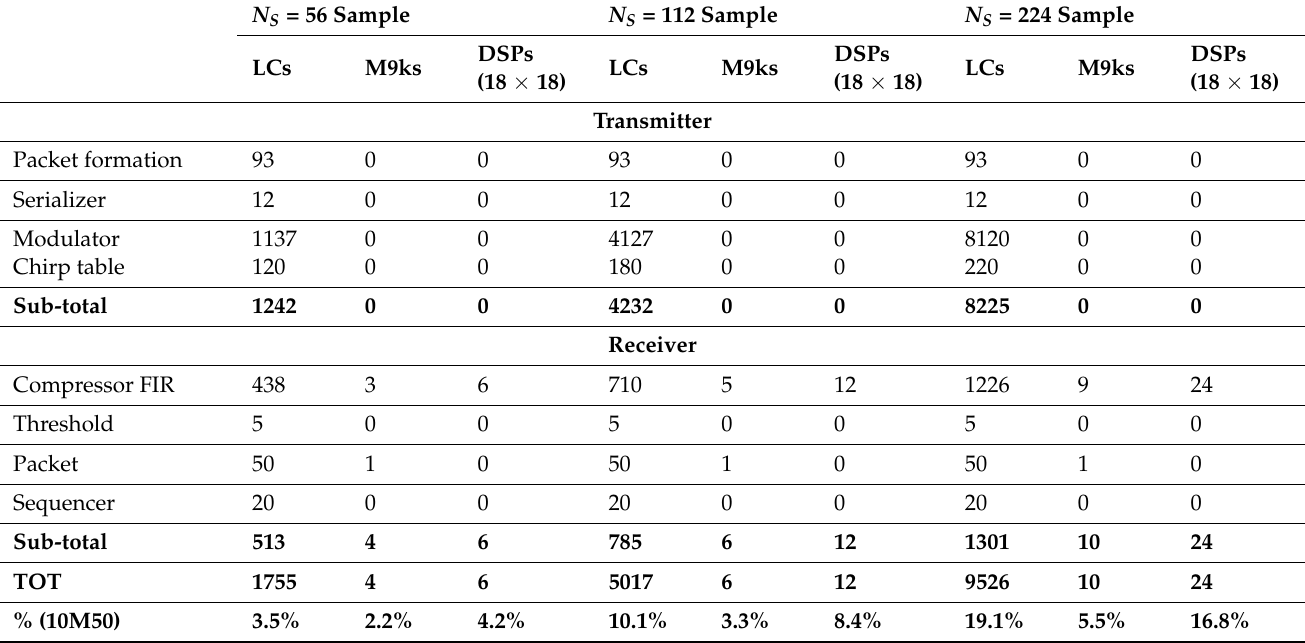
Table 2. Resources of MAX10 FPGA employed by the transmitter and